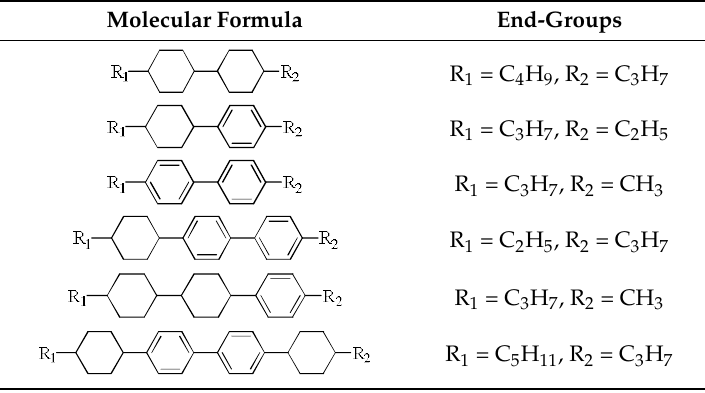
Table 1. The molecular formula of TS029 mixture.